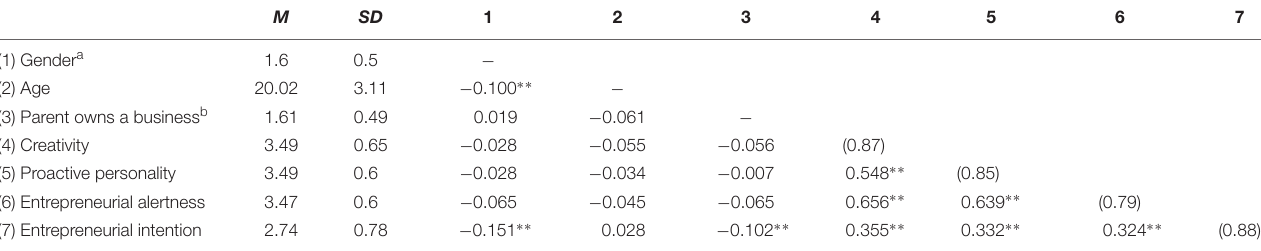
TABLE 1 | Descriptive statistics and correlations for the total sample. M SD